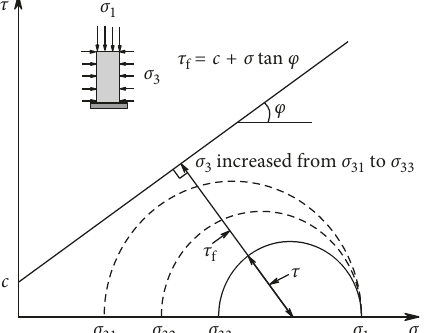
3 on bearing capacity or σ 1 .